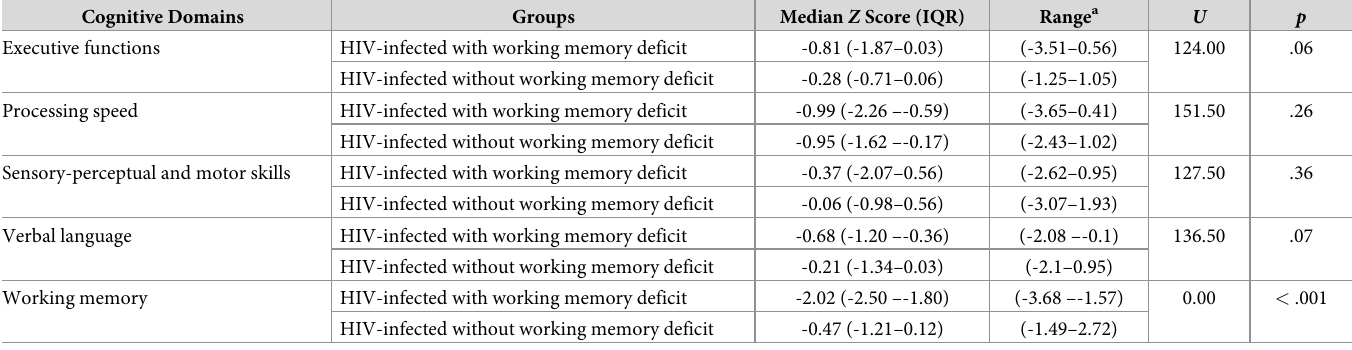
Table 3. Comparative analysis among groups on cognitive domains Z